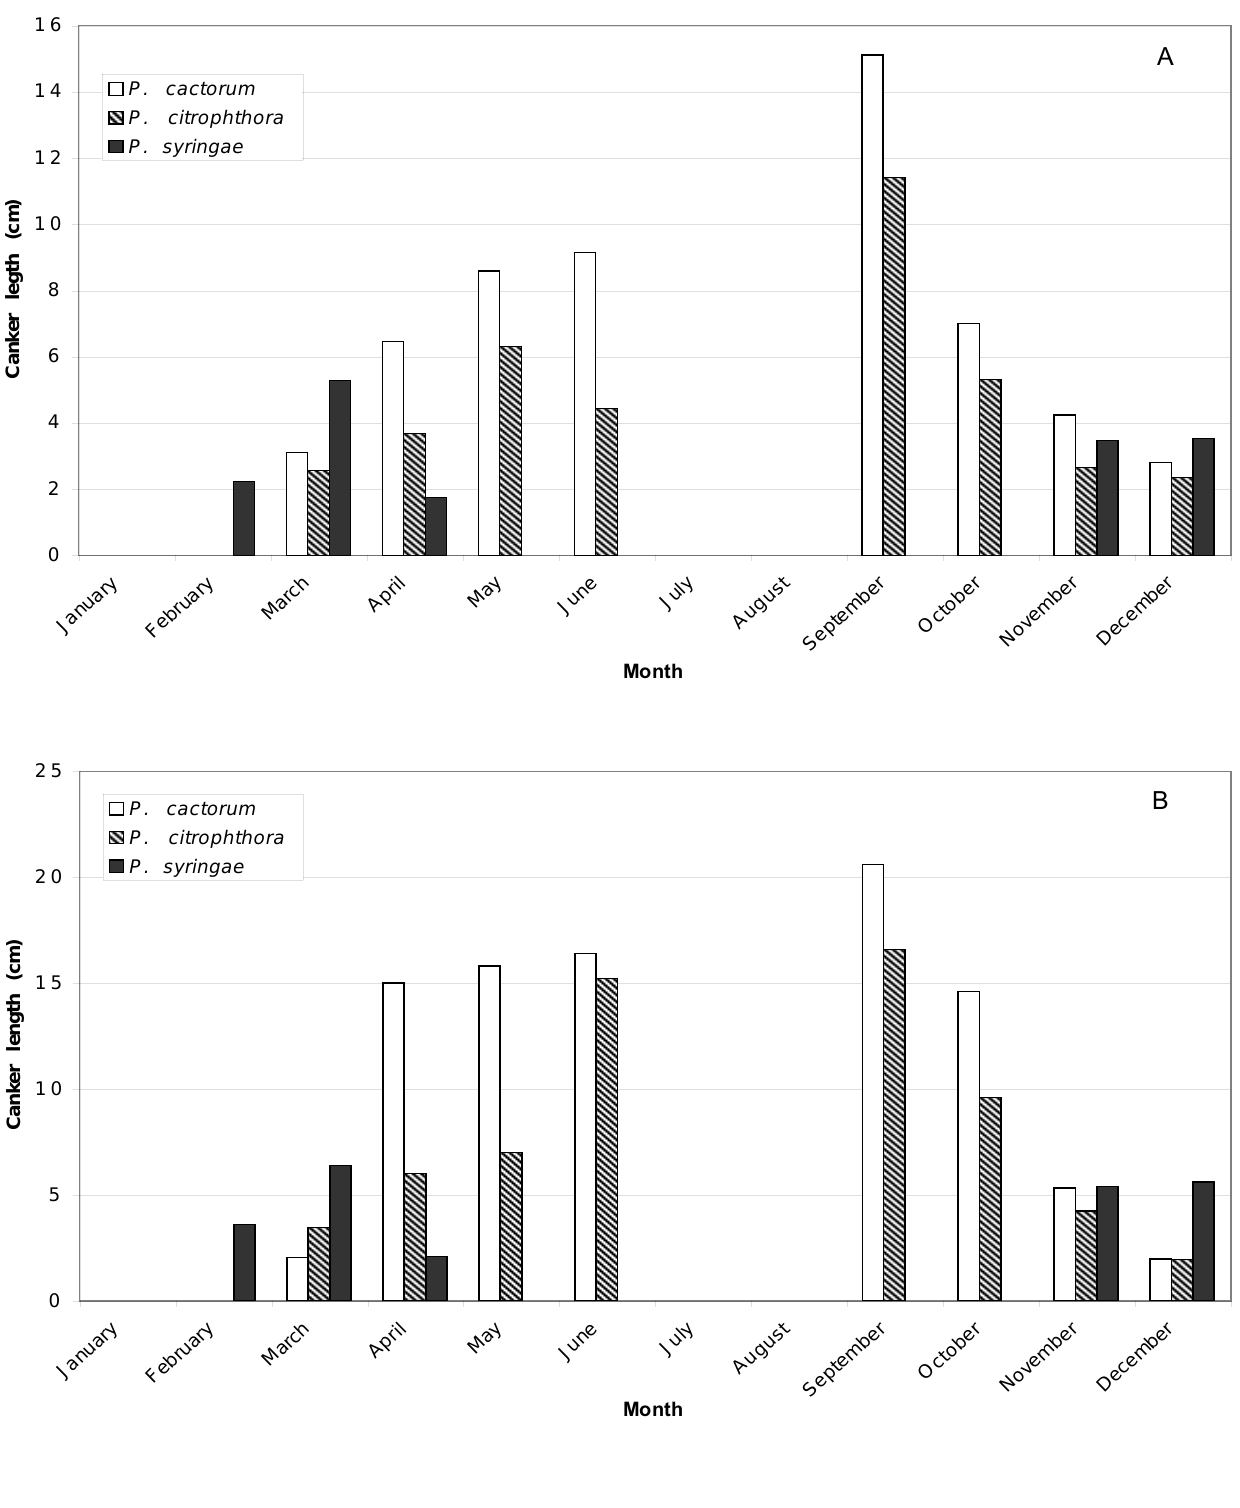
Fig. 2 Graphical representation of the data for planta of GF677 (A) and KID I (B) peach rootstocks shown in Table